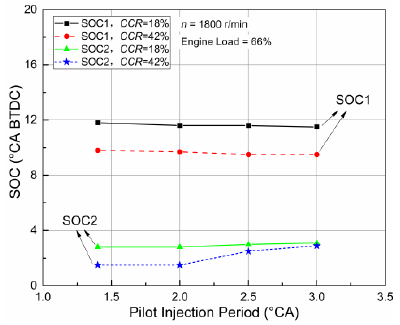
( b ) Figure 9. HRR and T under different pilot injection periods at 18% CCR ( a ) and 42% CCR ( b ). 3.2.3. Effect on SOC under Different CCR s Figure 10 illustrates the SOC1 and SOC2 under different pilot injection periods. As the pilot injection period is increased from 1.4 °CA to 3 °CA, the SOC1 is almost un-